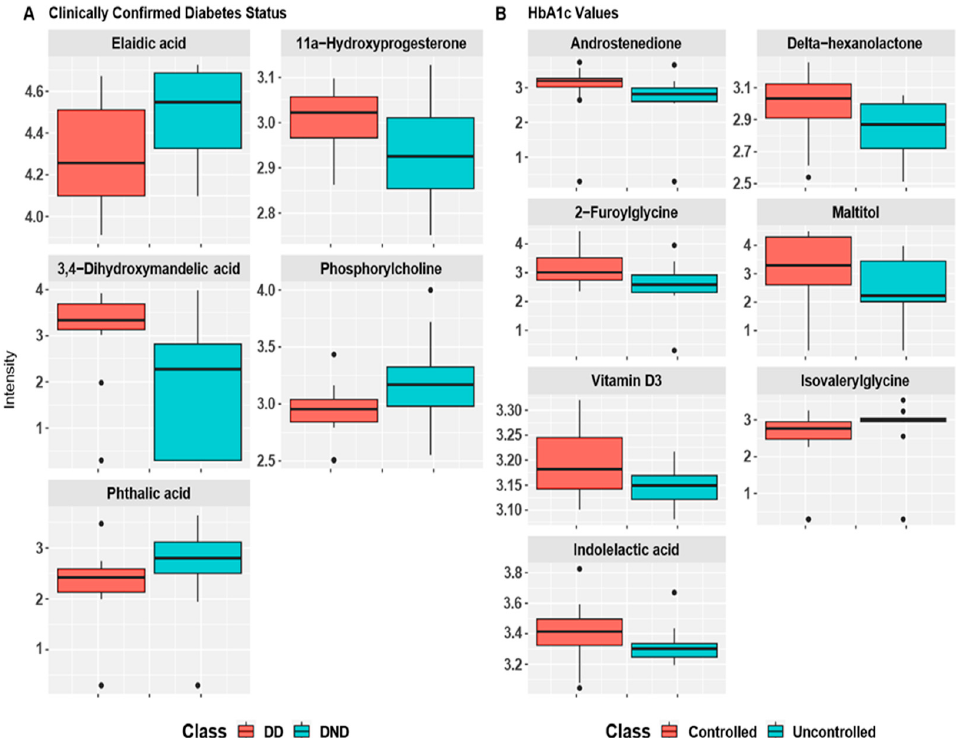
Figure 3. ( A ) Boxplot of normalized intensity metabolites for the clinically confirmed diabetic status; ( B ) boxplot of normalized intensity metabolites based on latest HbA1c values.